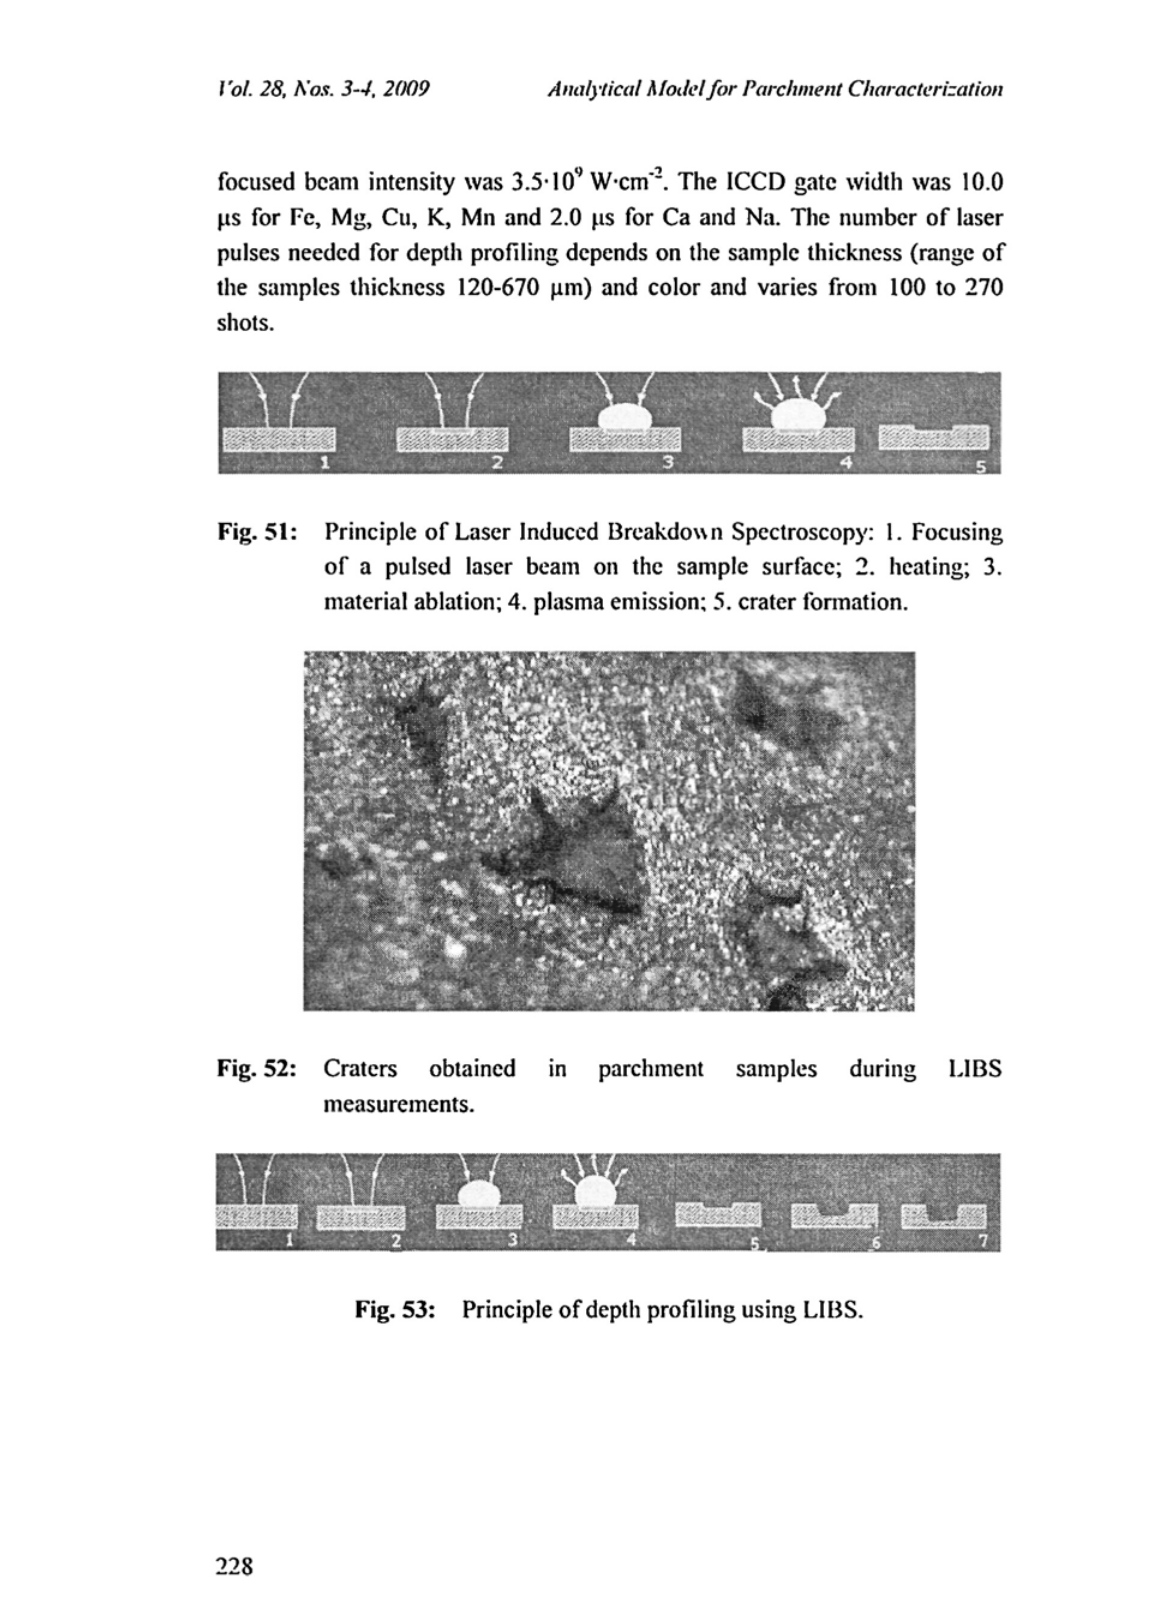
Fig. 53: Principle of depth profiling using